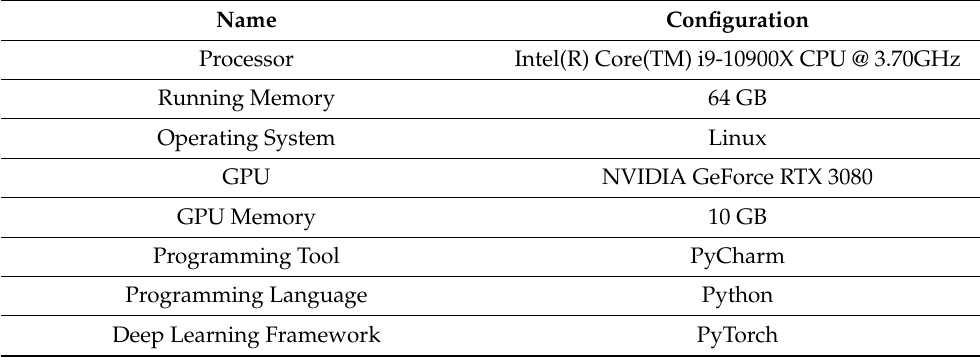
Table 1. Computation system.